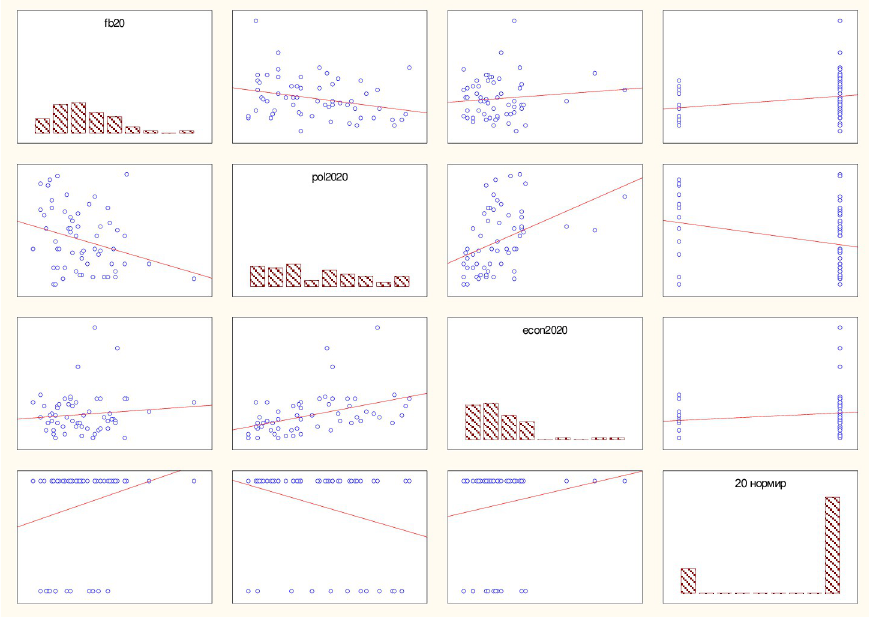
Fig 3. The results of building a logit model for assessing the economic, financial, budgetary and political- institutional development of countries as a result of the pandemic, 2020. Source: own